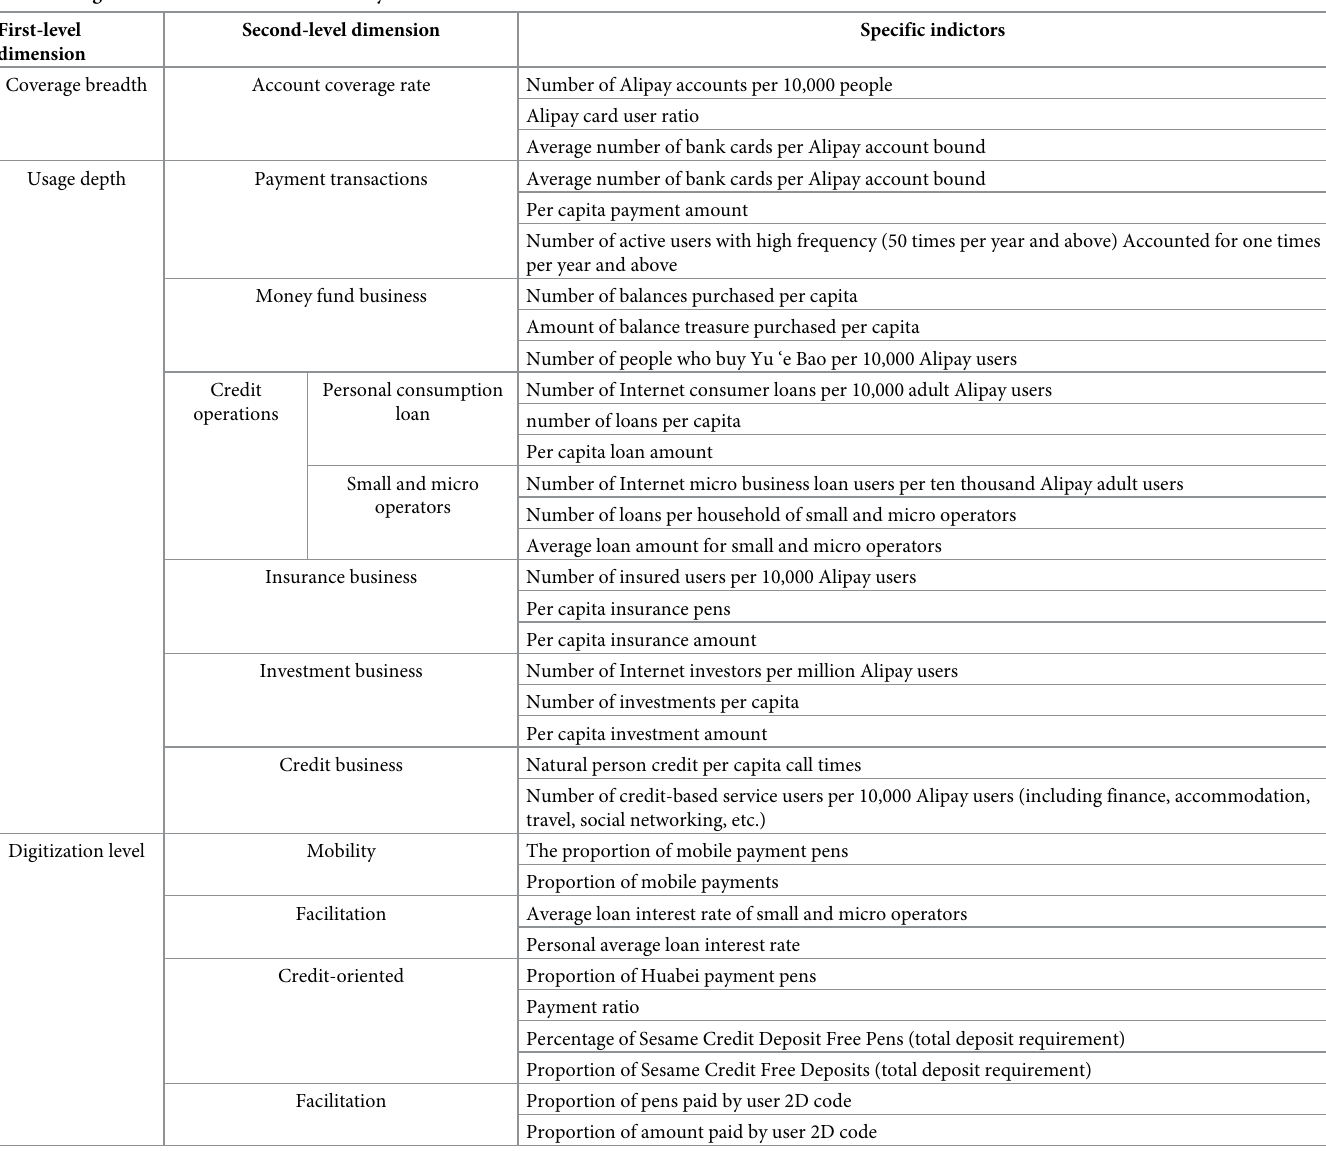
Table 1. Digital inclusive financial indicator